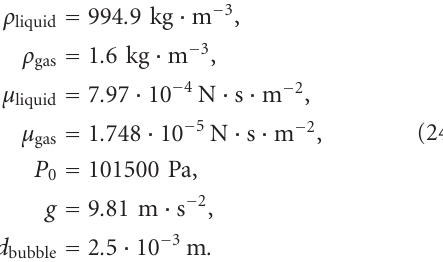
Figure 3: Radial profile of the liquid velocity, comparisons of turbulent dispersion forces with CL = 0 . 1.